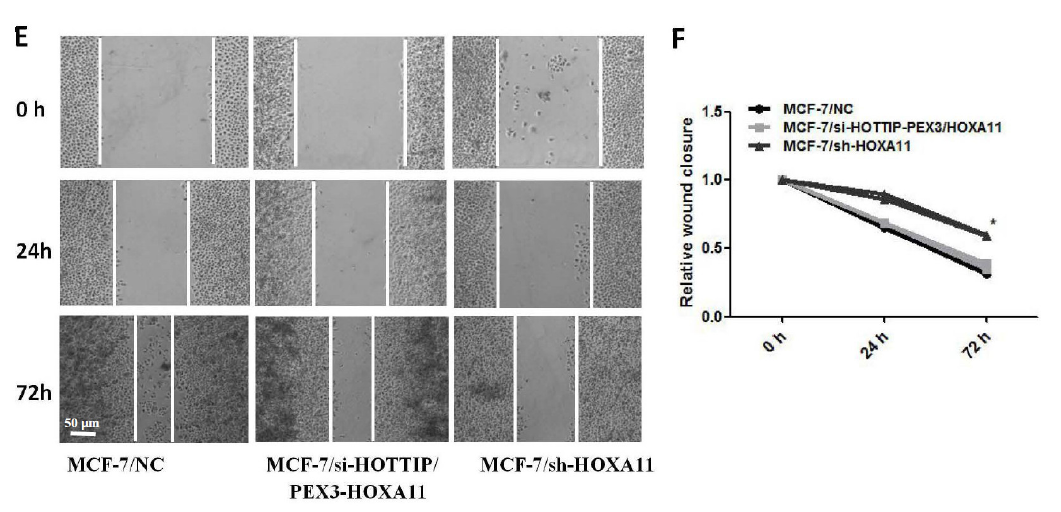
Figure 4. HOXA11 mediates the effect of HOTTIP on breast cancer pathogenesis. ( A ): Cell Counting Kit 8 (CCK-8) assay showed that HOXA11 overexpression could rescue the effect of HOTTIP/HOXA11 knockdown on MCF-7 cell proliferation. ( B ): Plate colony formation assay showed HOXA11 overexpression could rescue the effect of HOTTIP/HOXA11 knockdown on MCF-7 cell colony formation. ( C ): Quantitative results of MCF-7 cell colony formation in Figure 4B. ( D ): Flow cytometry showed HOXA11 overexpression could rescue the effect of HOTTIP/HOXA11 knockdown on MCF-7 cell apoptosis. ( E ): In vitro wound healing experiment showed HOXA11 overexpression could rescue the effect of HOTTIP/HOXA11 knockdown on MCF-7 cell migration; the figures of the wound healing experiment at 0 h, 24 h, and 72 h in MCF-7 cells are shown. ( F ): Quantitative results of the wound healing experiment in Figure 4E. * p < 0.05. Scale bar represents 50 µ